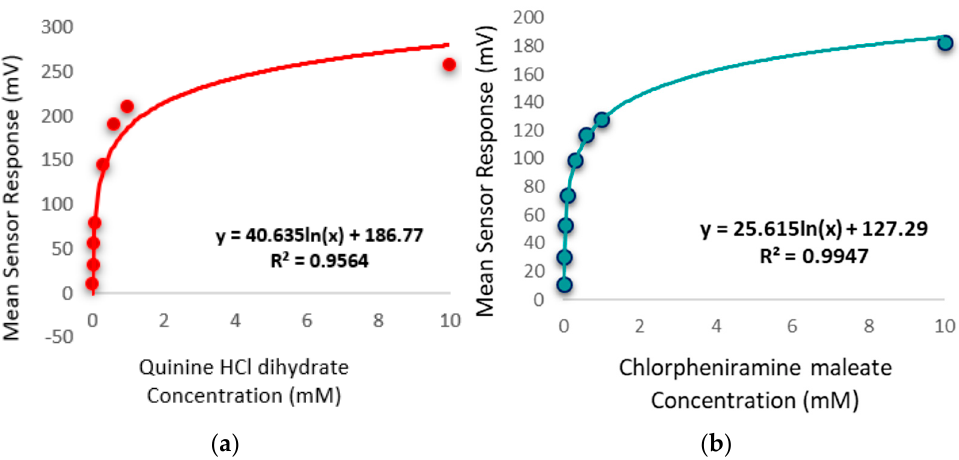
Figure 14. ( a ) Quinine HCl dihydrate response shown as a logarithmic trend-line as determined by BT0 sensor. ( b ) Chlorpheniramine maleate response shown as a logarithmic trend-line as determined by BT0 sensor.